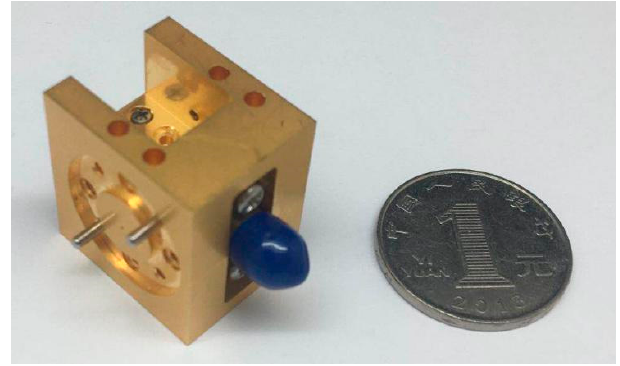
Figure 10. The photo of the assembled sub-harmonic mixer.